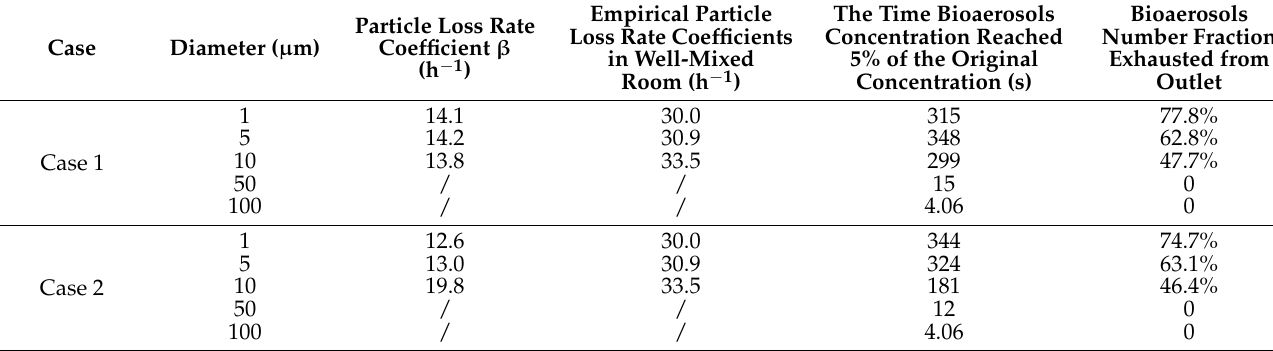
Figure 9. The final deposition of bioaerosols per unit area for Case 1: ( a ) 1 µm; ( b ) 5 µm; ( c ) 10 µm. Table 1. Comparison of Case 1 and Case 2 in terms of bioaerosol fates and ventilation